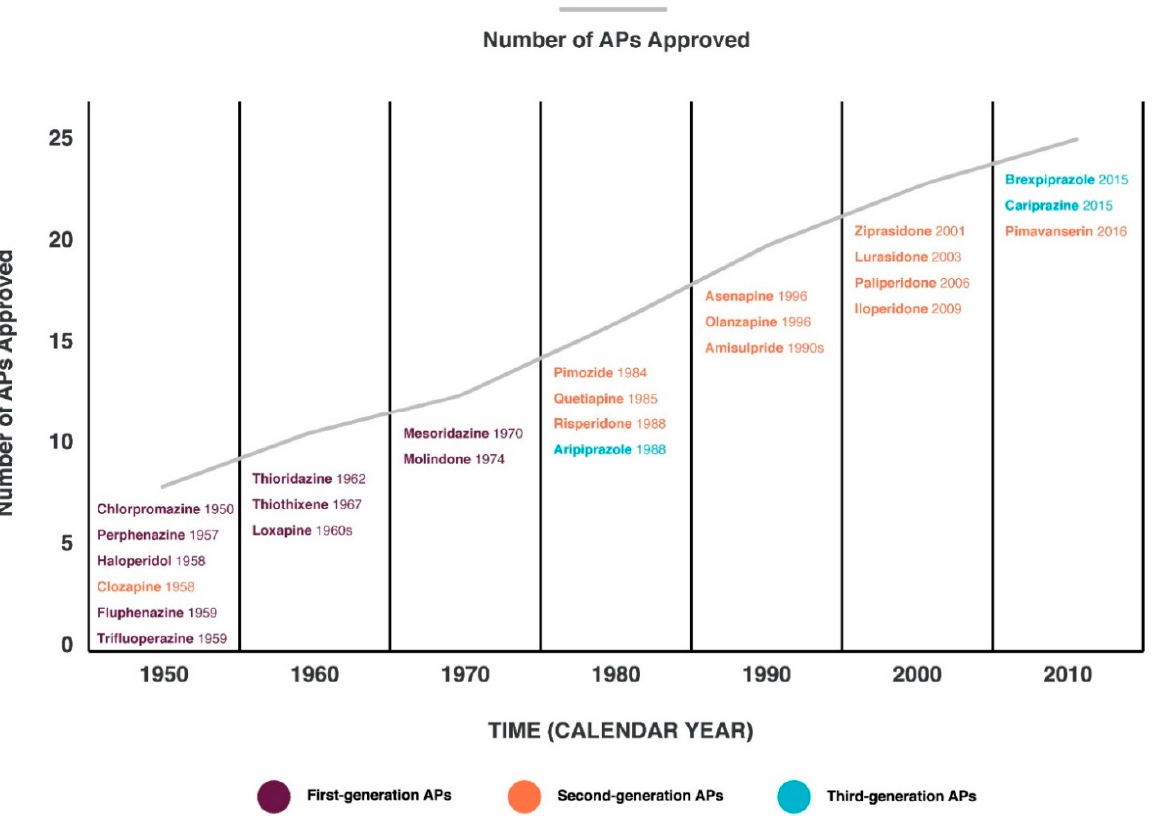
Figure 1. Timeline of antipsychotics (APs) approved by Food and Drug Administration (FDA) [9,11].